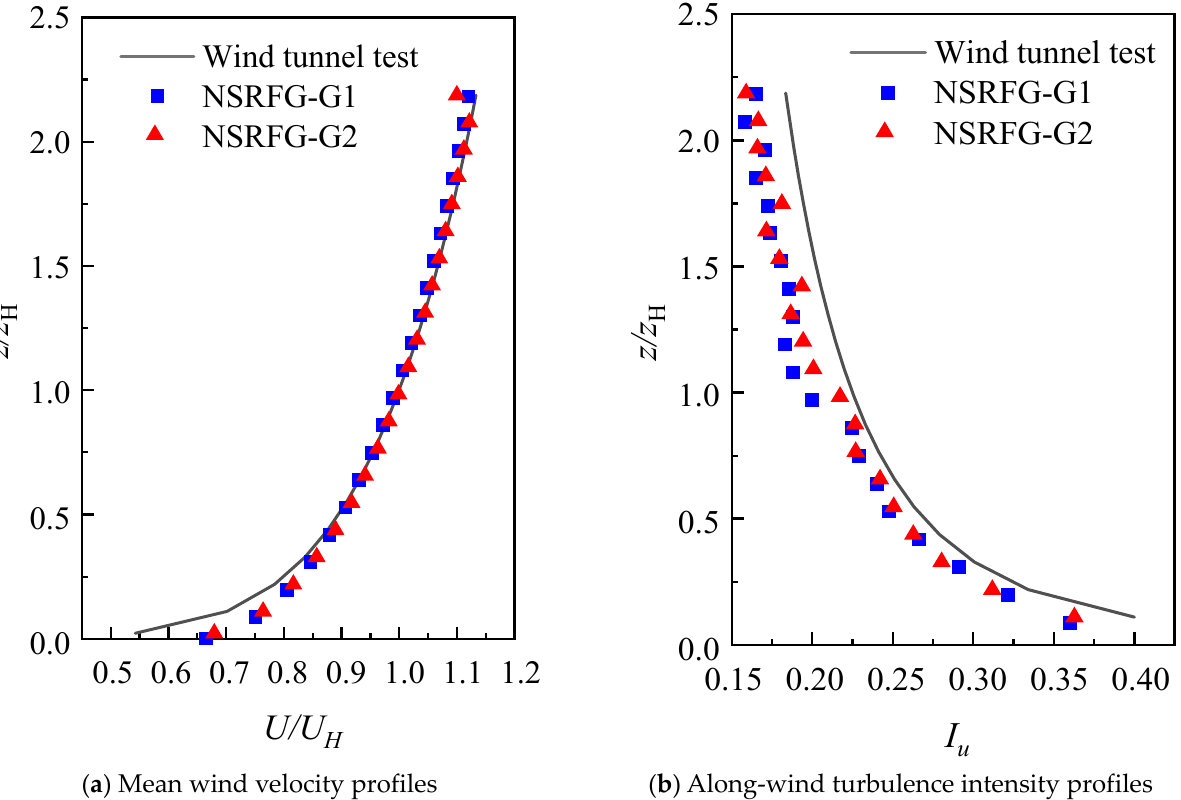
Figure 11. Mean wind velocity and turbulence intensity profiles at the center position of the CAARC model placed.